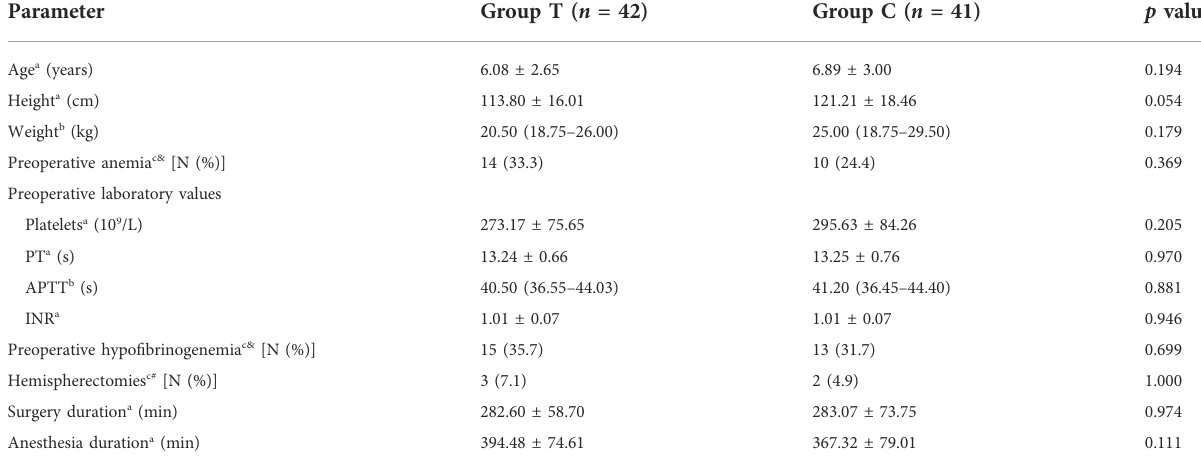
TABLE 1 Demographic and baseline characteristics of the two